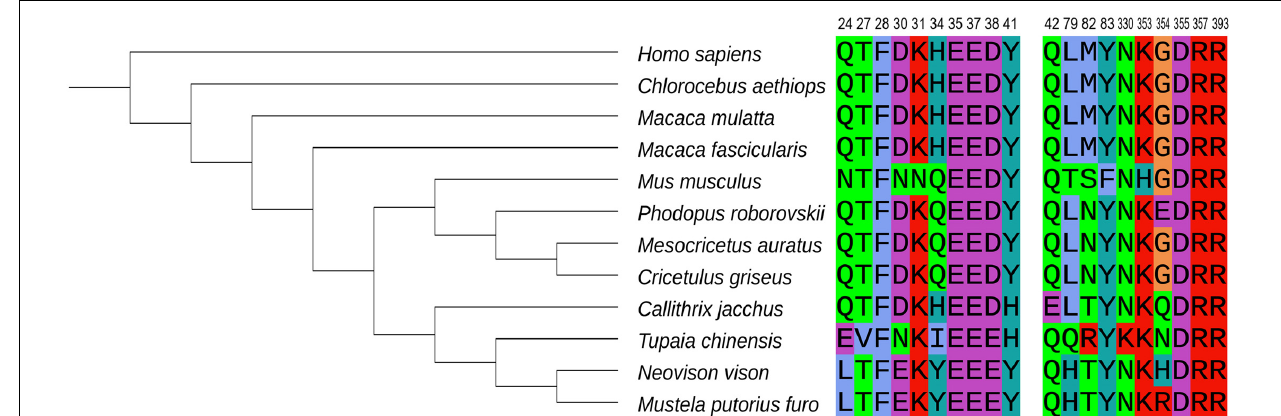
FIGURE 1 | Phylogenetic analysis of ACE2 orthologs of 12 species and crucial ACE2 residues at the interface with the viral S protein. National Center for Biotechnology Information (NCBI) accession numbers for ACE2 are as follows: NP_001358344.1 (human), XP_008987241.1 (marmoset), XP_027288607.1 (Chinese hamster), XP_005593094 (cynomolgus macaque), NP_001129168.1 (rhesus macaque), XP_005074266.1 (Syrian hamster), NP_001123985.1 (mouse), BAE53380.1 (ferret), QPL12211.1 (mink), QPL07045.1 (Roborovski dwarf hamster), XP_006164754.1 (tree shrew), and AAY57872.1 (African green monkey) were analyzed and the phylogenetic tree was accomplished by MGEA-X (version 10.0.5). The 20 amino acid residues at the interface between human ACE2 and SARS-CoV-2 RBD are shown on the right (Shang et al., 2020). Each amino acid is identified by a different color.